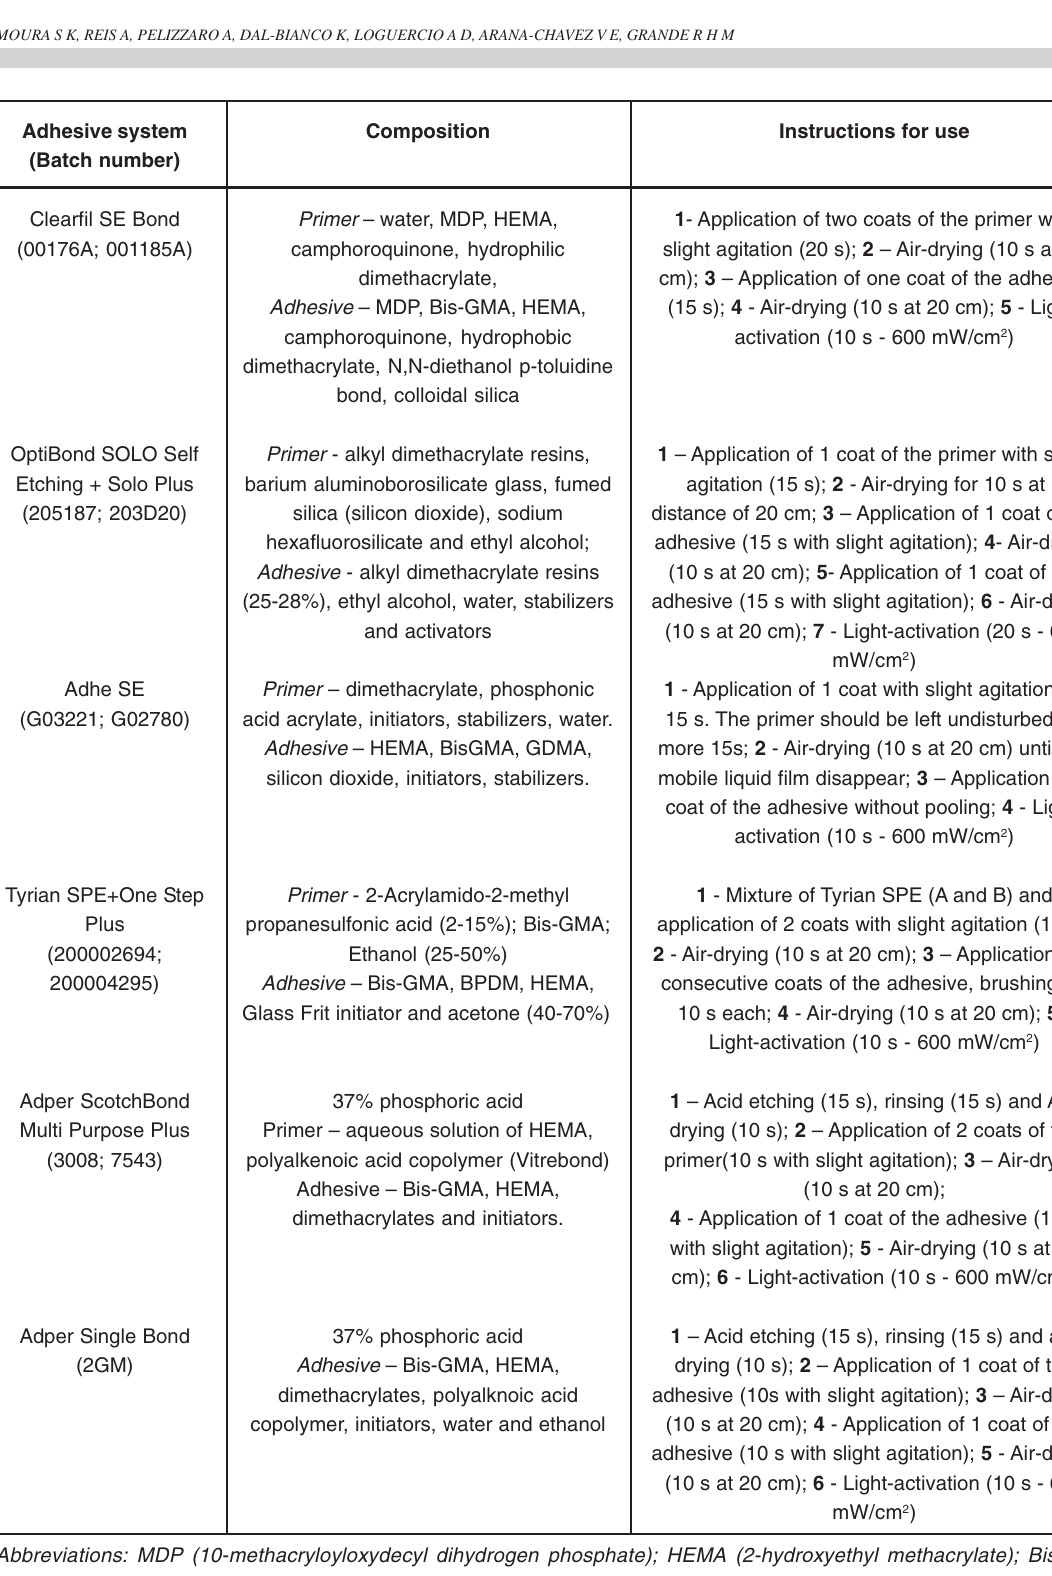
FIGURE 1- Adhesive systems, composition and directions for using